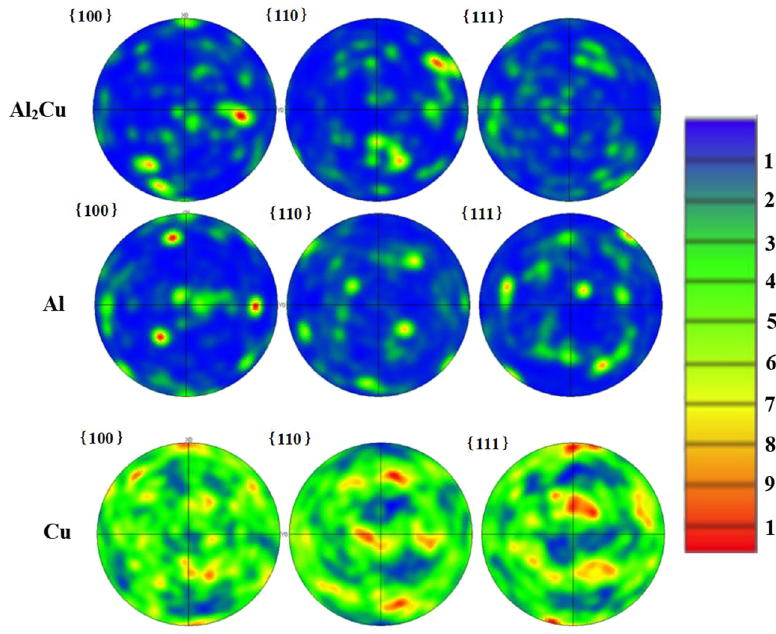
Figure 8: Pole fi gures of Cu, Al, and Al 2 Cu in the BAl88Si brazing